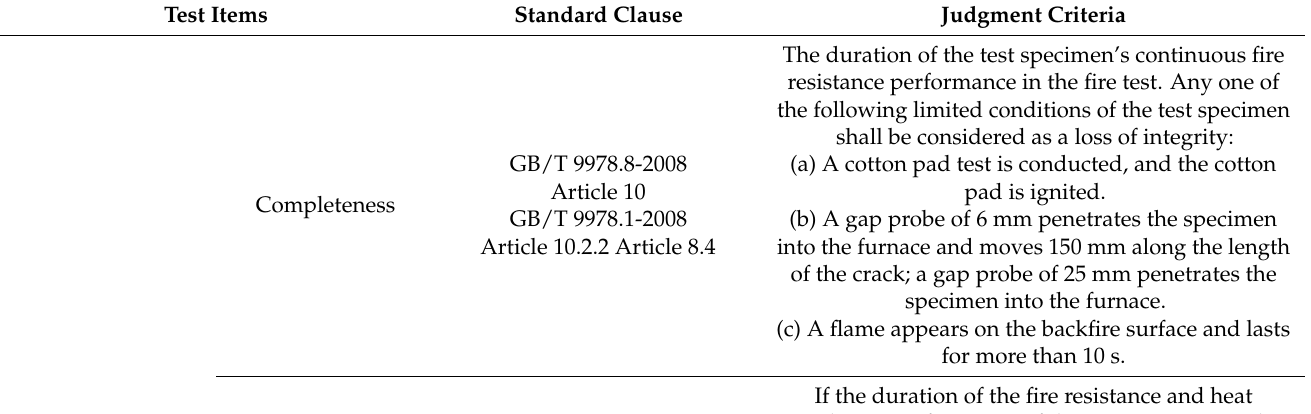
Table 1. Reference standards for fire resistance.